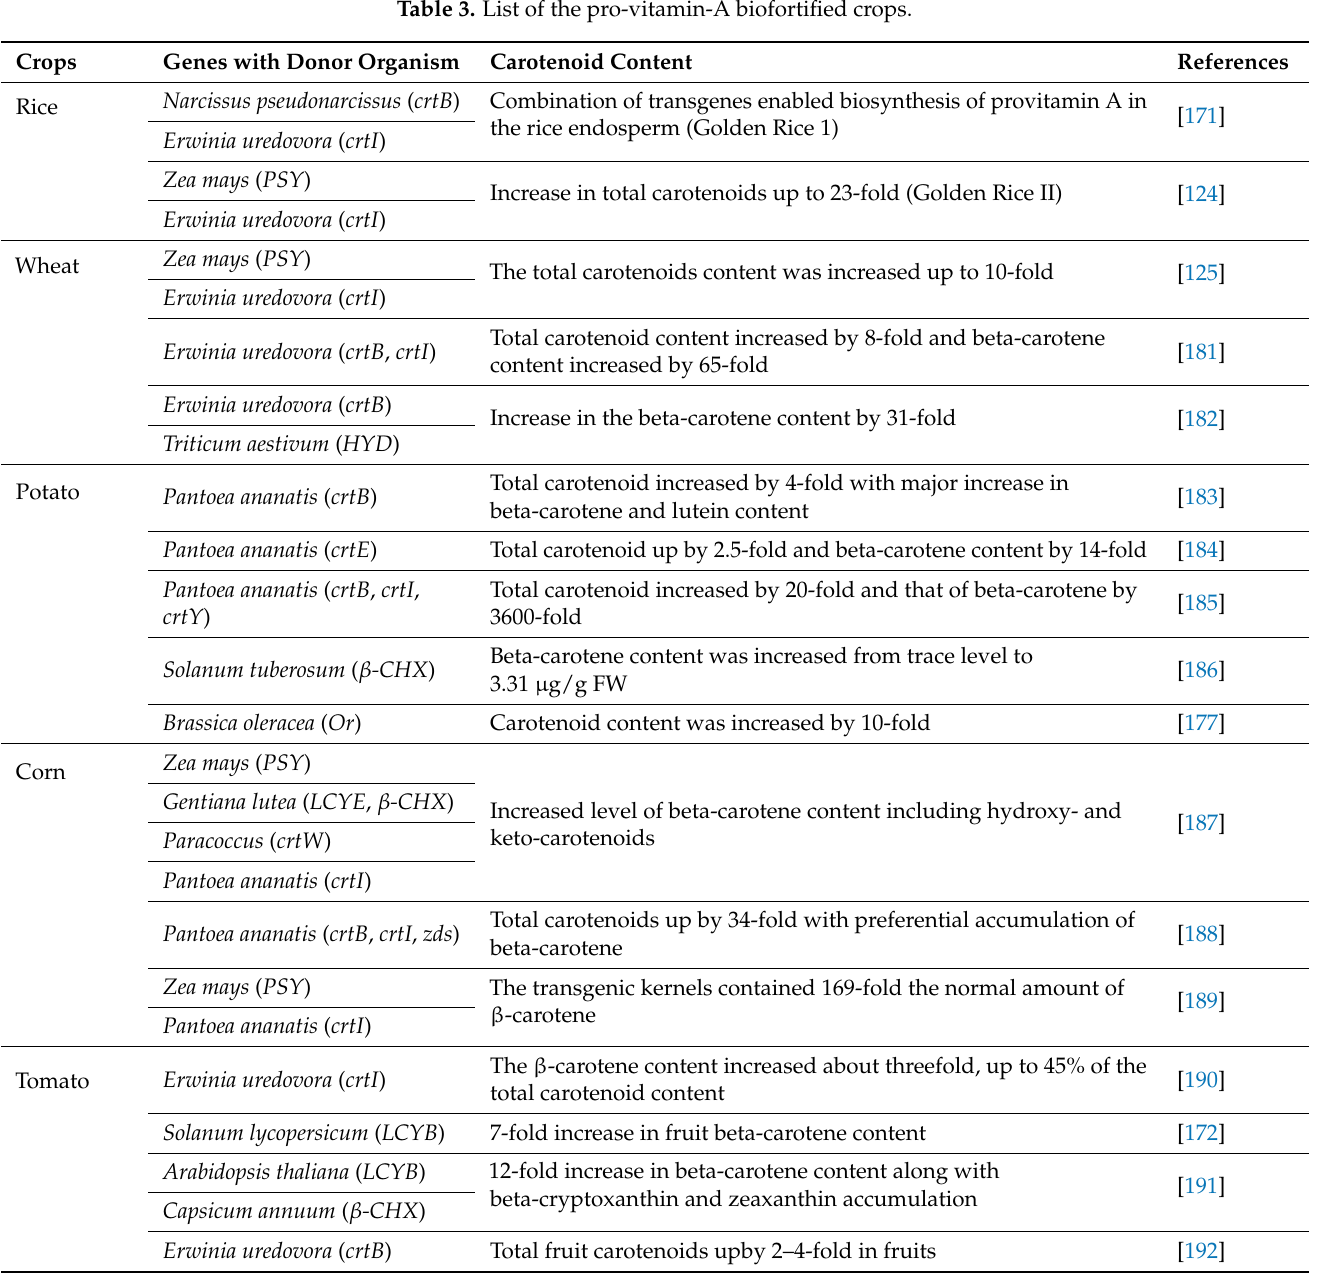
Table 3. List of the pro-vitamin-A biofortified